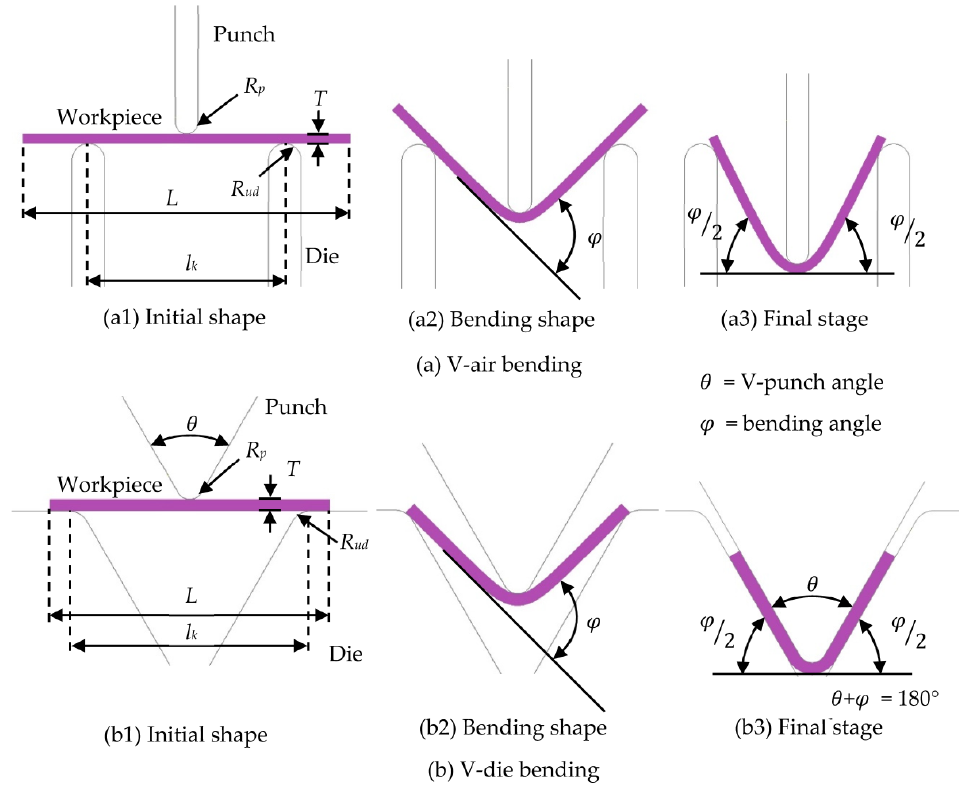
Figure 3. The model of V-air and V-die bending. Table 1. Finite element simulation and experimental conditions.